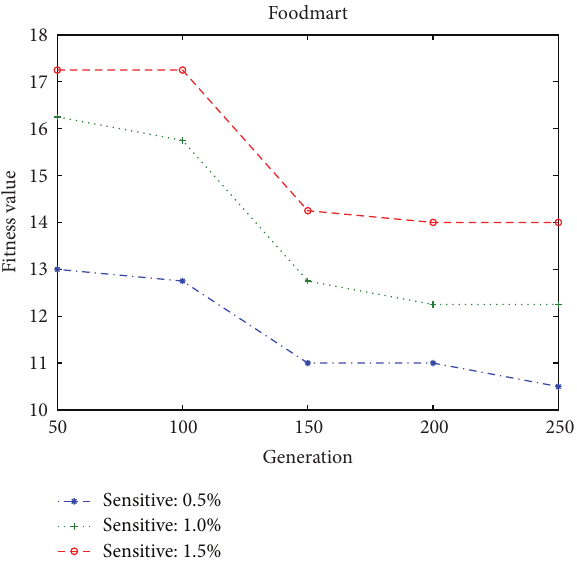
Figure 7: Fitness values in different percentages of sensitive high utility itemsets in the foodmart database.